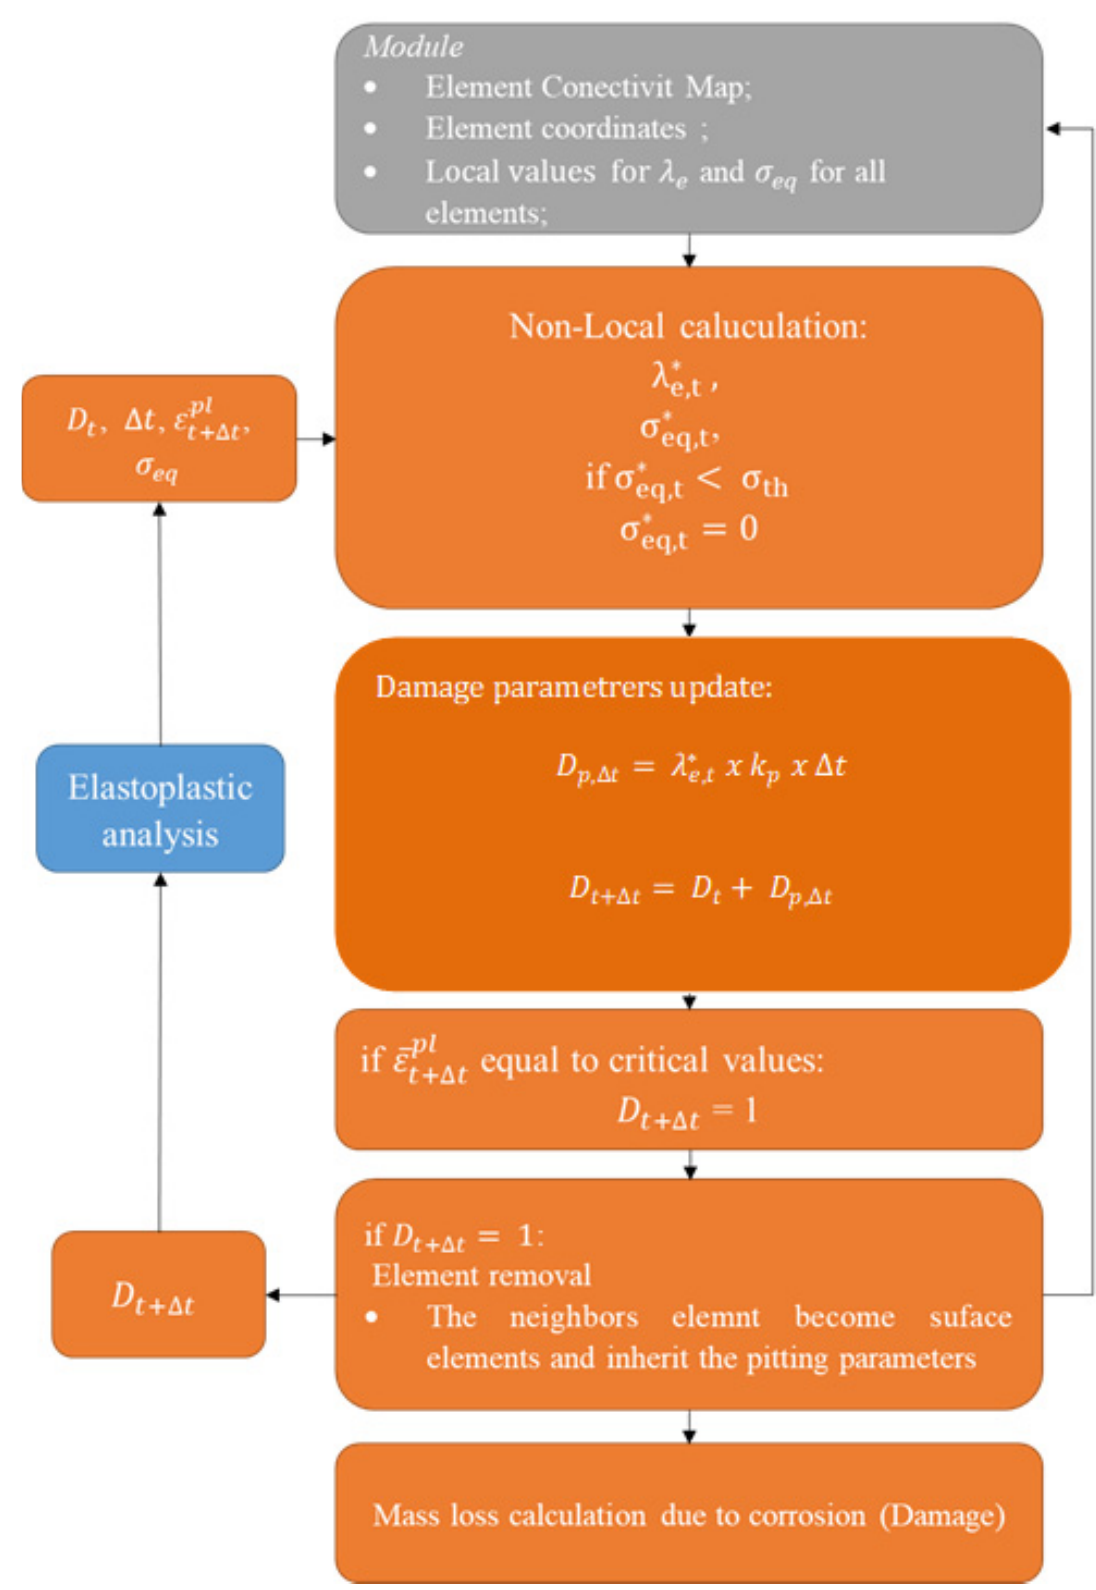
Figure 4. Operation flowchart of the “DAMAGE” subroutine.